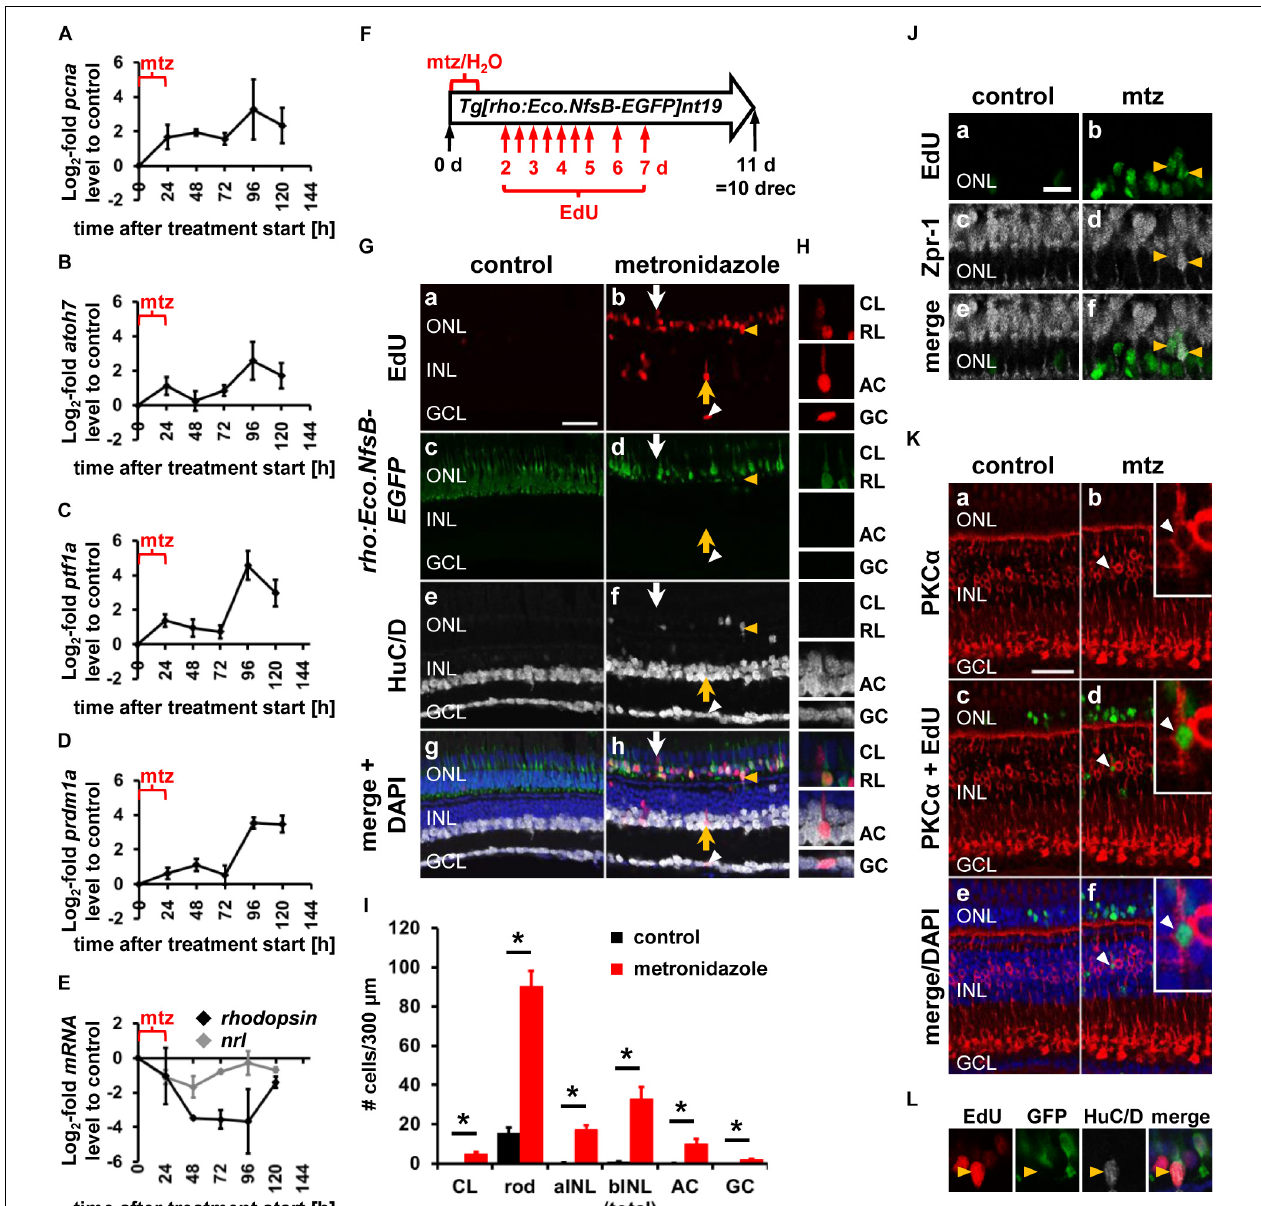
FIGURE 8 | Expression of developmental competence factors and generation of all neuronal cell types following rod photoreceptor cell death in a genetic ablation model. (A–E) Line plots displaying mRNA expression levels expressed as log 2 -fold changes relative to 0 h controls for pcna (A) , atoh7 (B) , ptf1a (C) , prdm1a (D) , nrl ( E , gray line), and rhodopsin ( E , black line) following metronidazole-induced rod photoreceptor cell death in Tg[rho:Eco.NfsB-EGFP]nt19 zebrafish (24, 48, 72, 96, and 120 h after metronidazole treatment onset). Mean ± SE, n ≥ 3. (F) Schematic of the experimental paradigm: Tg[rho:Eco.NfsB-EGFP]nt19 zebrafish were either exposed to metronidazole (mtz) or system water (H 2 O) for 24 h and subsequently recovered in system water for 10 days (10 drec). Intraperitoneal EdU injections at the indicated timepoints (red arrows). (Ga–h,H,L) Single z -plane confocal images of retinal sections from metronidazole or water-exposed EdU-injected Tg[rho:Eco.NfsB-EGFP]nt19 zebrafish (Ga,b,g,h) at 10 drec that were labeled for GFP (Gc,d,g,h) , HuC/D (Ge–h) , and DAPI (Gg,h) . Arrowhead, GCL EdU-positive ganglion/amacrine cell; yellow arrow, INL EdU-positive amacrine cell; white arrow, EdU-positive cell in the cone nuclear layer. Scale bar, 20 µ m (Ga) . (H) EdU-positive cells in panel (Ab) (arrows, white arrowhead) at higher magnification. (I) Number of EdU-positive cells in the cone nuclear layer, apical and basal INL and those identified as rod photoreceptor cells by co-labeling with rho:Eco.NfsB-EGFP , as amacrine and ganglion cells based on the expression of HuC/D in the basal INL or GCL, respectively, at 10 drec following exposure of Tg[rho:Eco.NfsB-EGFP]nt19 zebrafish to either system water (control) or metronidazole for 24 h. Mean ± SE, n ≥ 9, Student’s t -test, p < 0.05. (J,K) Single z -plane confocal images from water or metronidazole-exposed EdU-injected (Ja,b,e,f,Kc–f) Tg[rho:Eco.NfsB-EGFP]nt19 zebrafish at 10 drec that were labeled for Zpr-1 (Jc–f) or PKC α (Ka–f) and counterstained with DAPI (Ke,f) . Yellow arrowheads (J) , Zpr-1 & EdU-double positive cells; white arrowhead (K) , PKC α & EdU-positive cell. (L) EdU & HuC/D-double positive ONL cell (yellow arrowhead) in panel (G) at higher magnification. aINL, apical inner nuclear layer; bINL, basal inner nuclear layer; CL, cone nuclear layer; RL, rod nuclear layer; mtz, metronidazole.